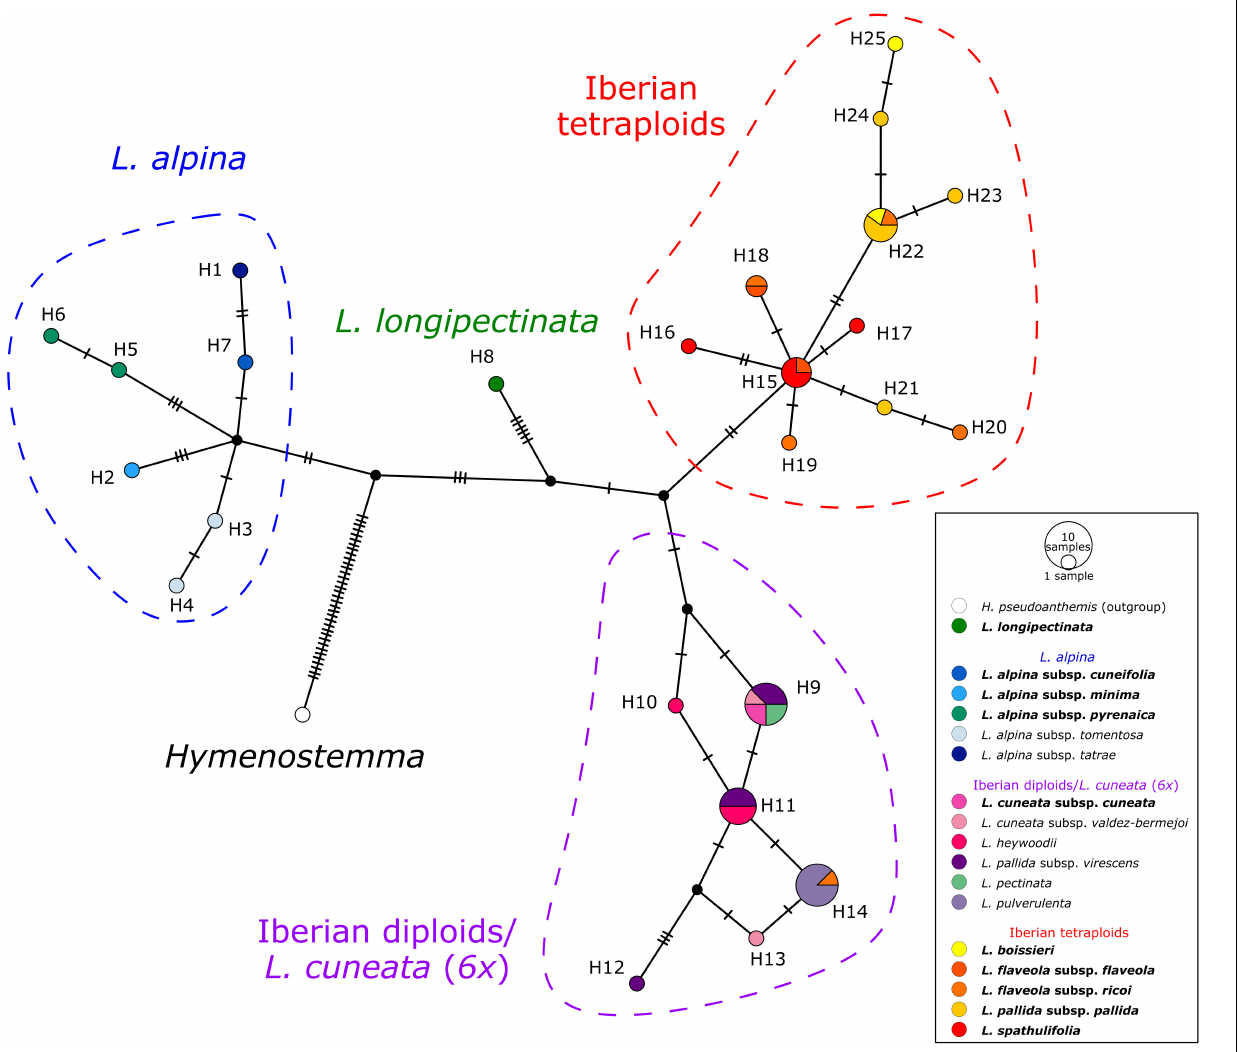
FIGURE 5 | TCS haplotype network of Leucanthemopsis based on two plastid intergenic spacers, psbA-trnH and trnC-petN . Circle (haplotypes) sizes are proportional to the number of samples. Small black circles represent hypothetical haplotypes and tick lines are mutational steps separating haplotypes. Colored dashed lines indicate haplotype groups (blue: L. alpina s.l.; red: Iberian tetraploids; purple: Iberian diploids), whereas the colors of haplotypes correspond to the taxa as in the legend and Figure 1 . Names of the taxa including polyploids are in bold.